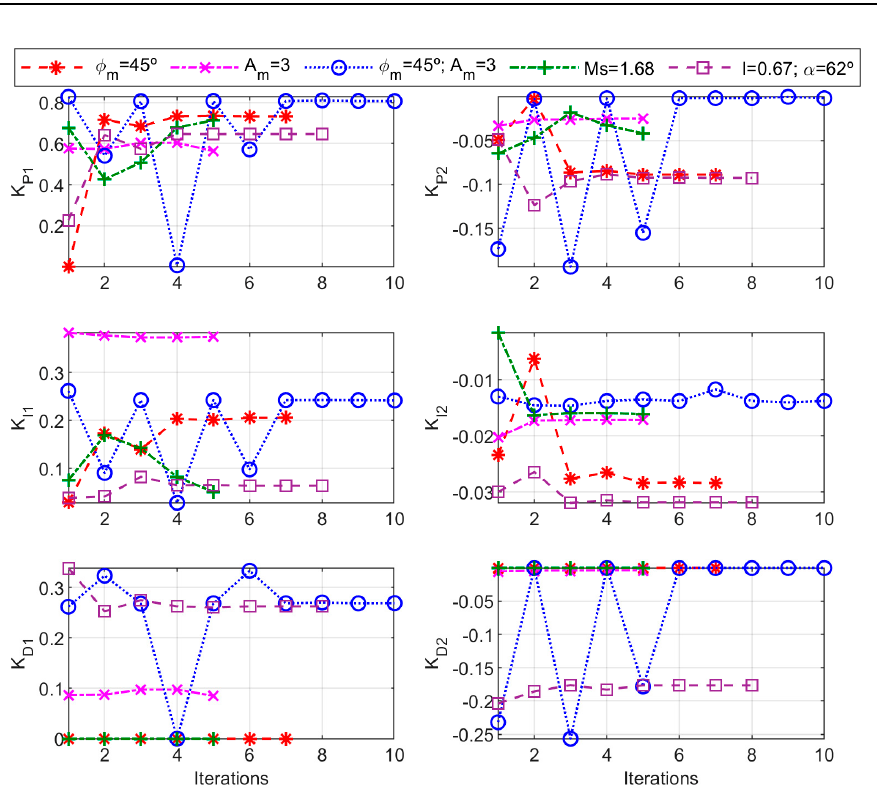
Figure 8. Changes of PID parameters through the proposed iterative procedure for different specifications in example 1.